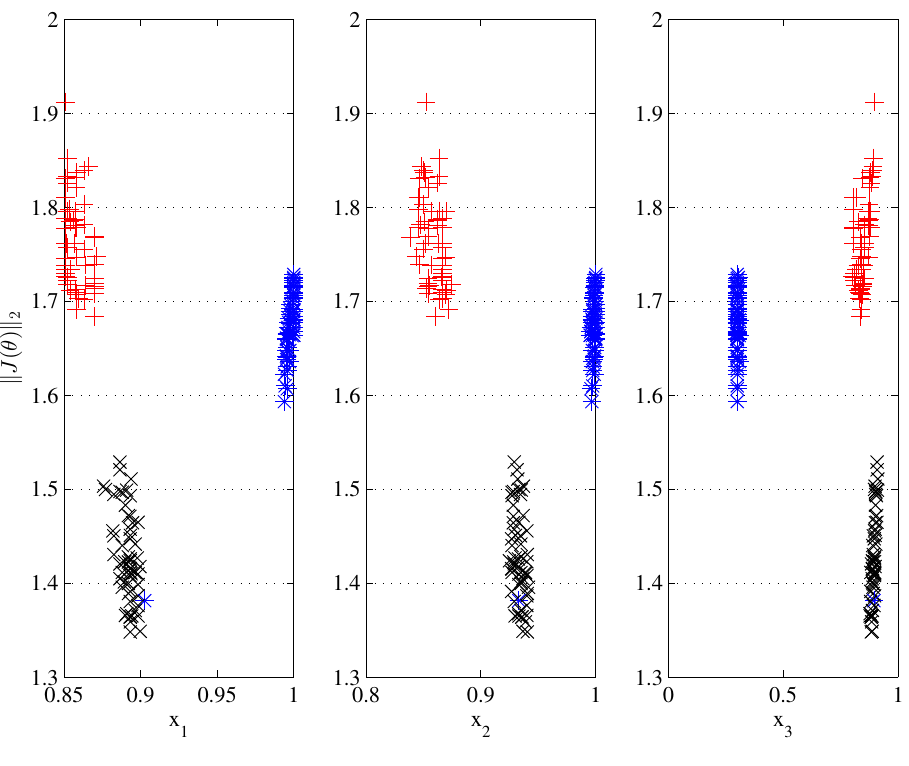
Figure 4. Pareto set approximation for MOP II with preference pruning: PP (red + ), PROMETHEE II (blue ∗ ) and TOPSIS (black